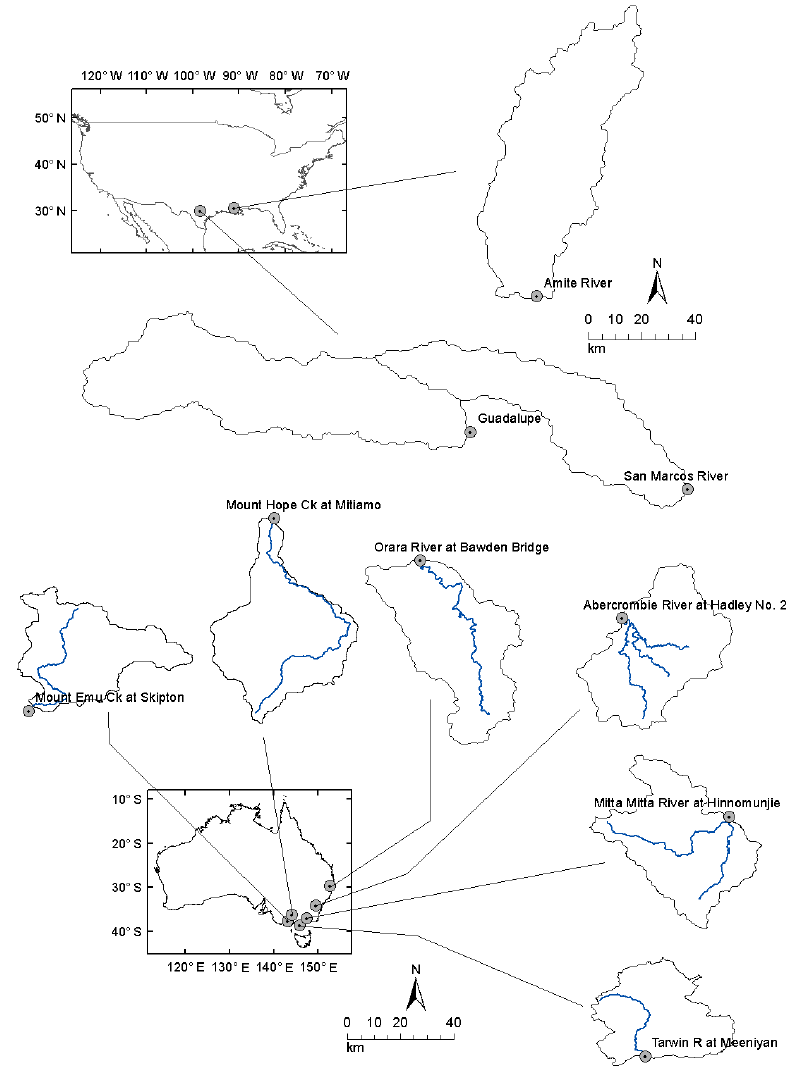
Figure 1. Map of the catchments used in this study.